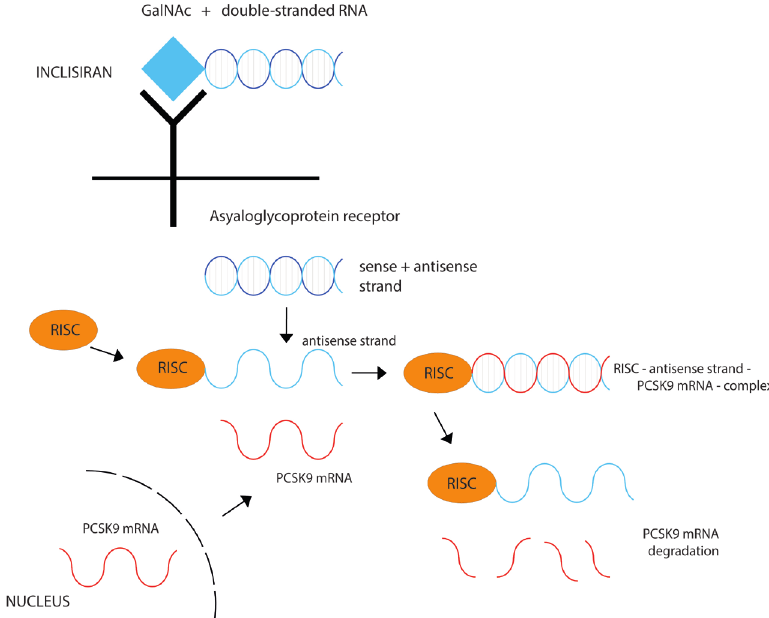
Figure 2. Mechanism of LDL cholesterol-lowering effect of inclisiran. Inclisiran consists of double- stranded RNA conjugated with N-acetylgalactosamine carbohydrates (GalNAc). GalNAc modifi- cation of inclisiran allows specific binding to asialoglycoprotein receptors present on hepatocytes. After its uptake by the liver cells, inclisiran binds RISC, as well as mRNA encoding PCSK9. In that way, the inclisiran–RISC complex degrades mRNA and prevents PCSK9 synthesis. RISC—RNA in- duced silencing complex; mRNA— messenger RNA; PCSK9 —Proprotein Convertase Subtil- isin/Kexin type 9.